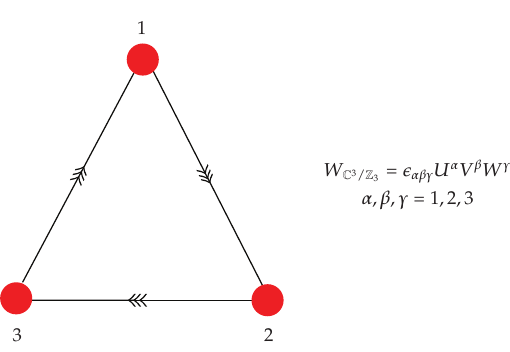
Figure 2: The quiver diagram and superpotential for dP 0